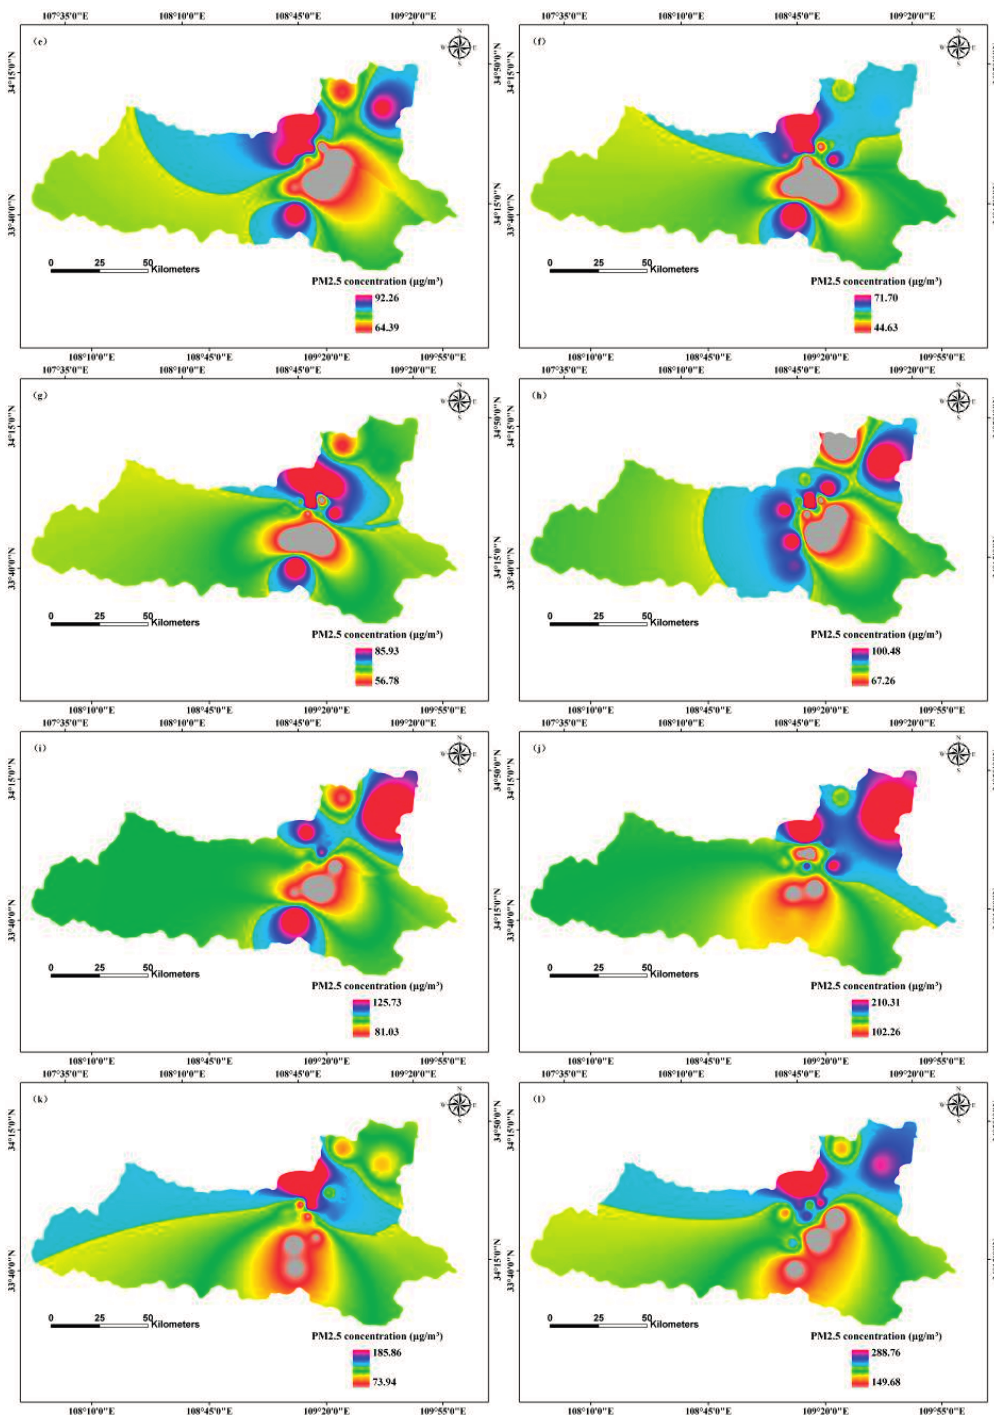
Figure 3. Simulation of temporal and spatial changes of PM2.5 concentration based on a BP-ANN model in 2013, Xi’an, China by month: ( a ) January; ( b ) February; ( c ) March; ( d ) April; ( e ) May; ( f ) June; ( g ) July; ( h ) August; ( i ) September; ( j ) October; ( k ) November; ( l )